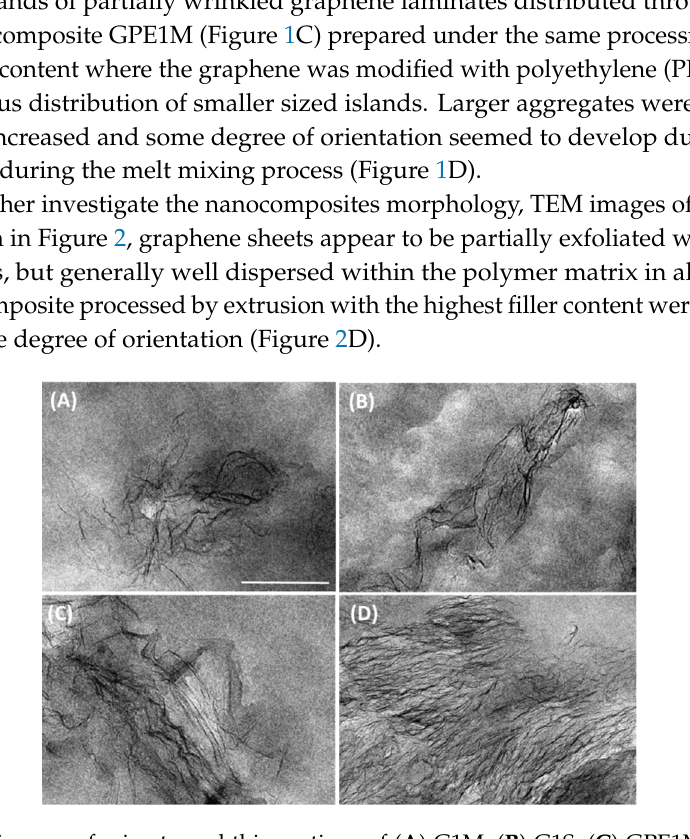
Figure 2. TEM images of microtomed thin sections of ( A ) G1M, ( B ) G1S, ( C ) GPE1M, ( D ) GPE3M. The scale bar applies for all samples and corresponds to 200 nm.